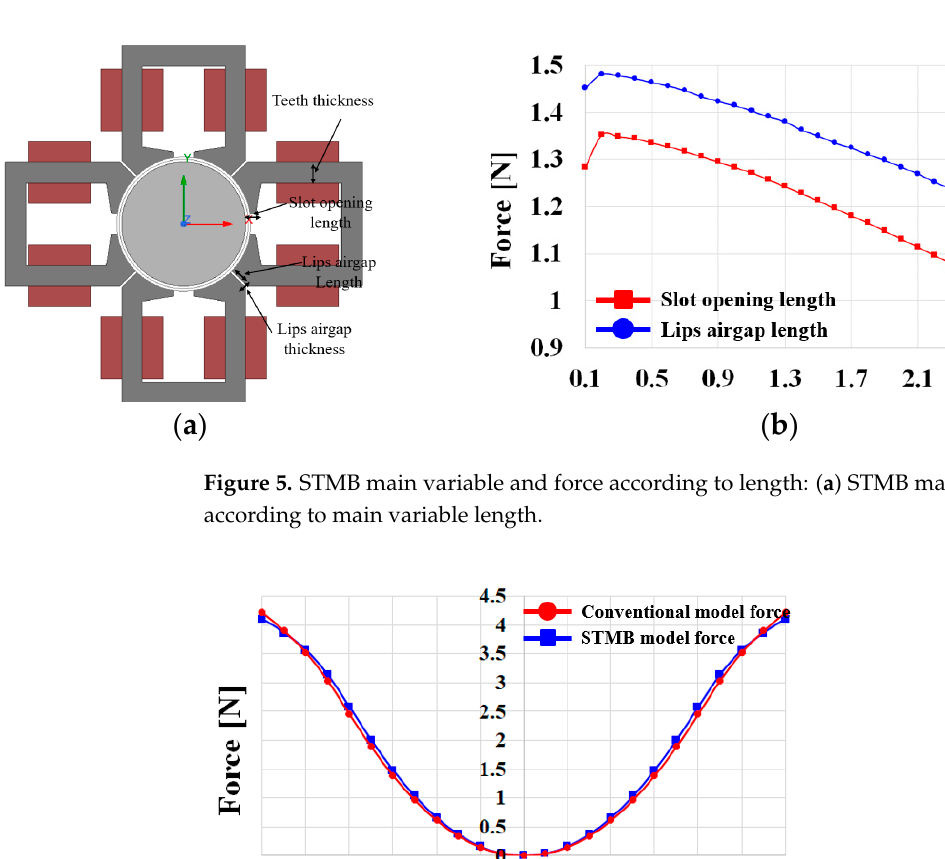
Figure 4. STBM creation process.